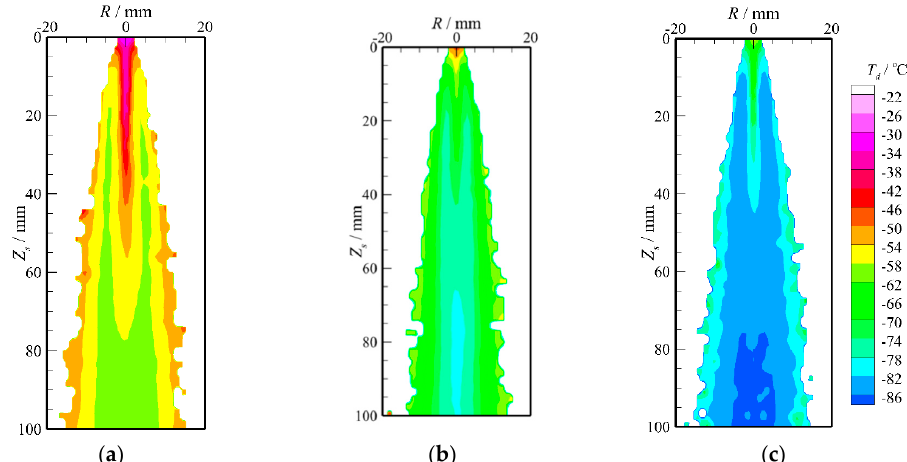
Figure 11. Comparison of droplet temperature distributions at axial section: ( a ) R134a, ( b ) R404A and ( c ) R32.